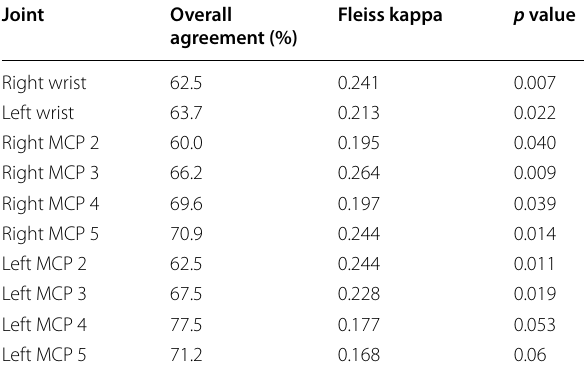
MCP, metacarpophalangeal; PIP, proximal interphalangeal